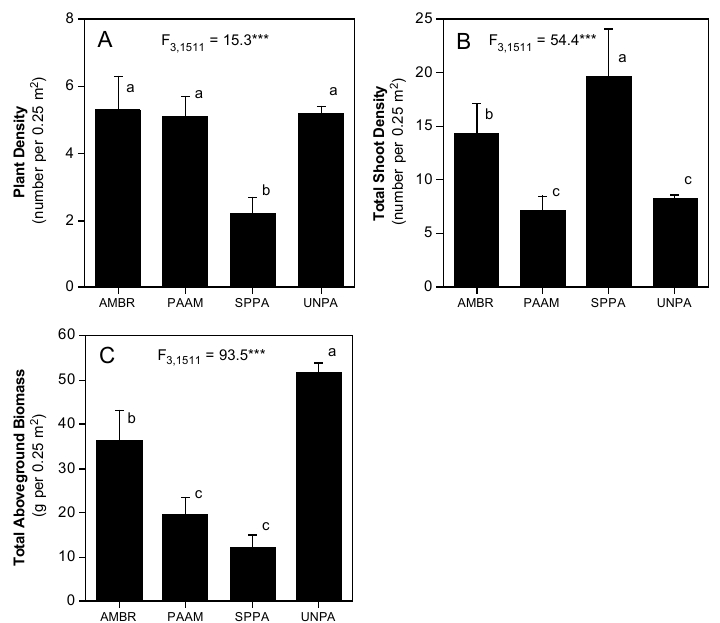
Figure 6. Comparisons (mean ± 95% CI per 0.25 m 2 ) of species growth form, measured as ( A ) plant density, ( B ) total shoot density, and ( C ) total plant biomass of the four most common dune grass species (abbreviations in Figure 4). One-factor ANOVA results are given in plots. Bars that do not share letters are significantly different (Tukey’s HSD p ≤ 0.05). *** p < 0.0001. Diversity 2019 , 11 , x FOR PEER REVIEW